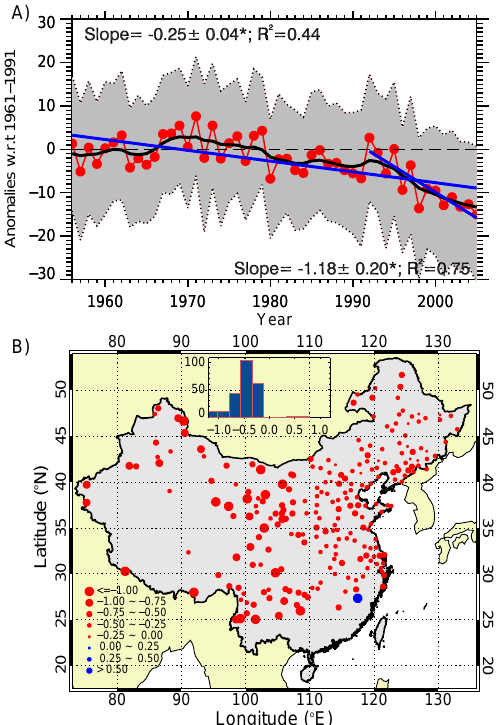
Figure 6. Same as Fig. 3 except for the number of days of the near- surface soil freeze. autumn and spring air temperatures, but also by changes in air temperature during the entire cold season. The freeze index of air temperature (AFI) is a measure of 1 July in the current year through 30 June in the next year, in order to cover the entire freeze period (Zhang et al.,